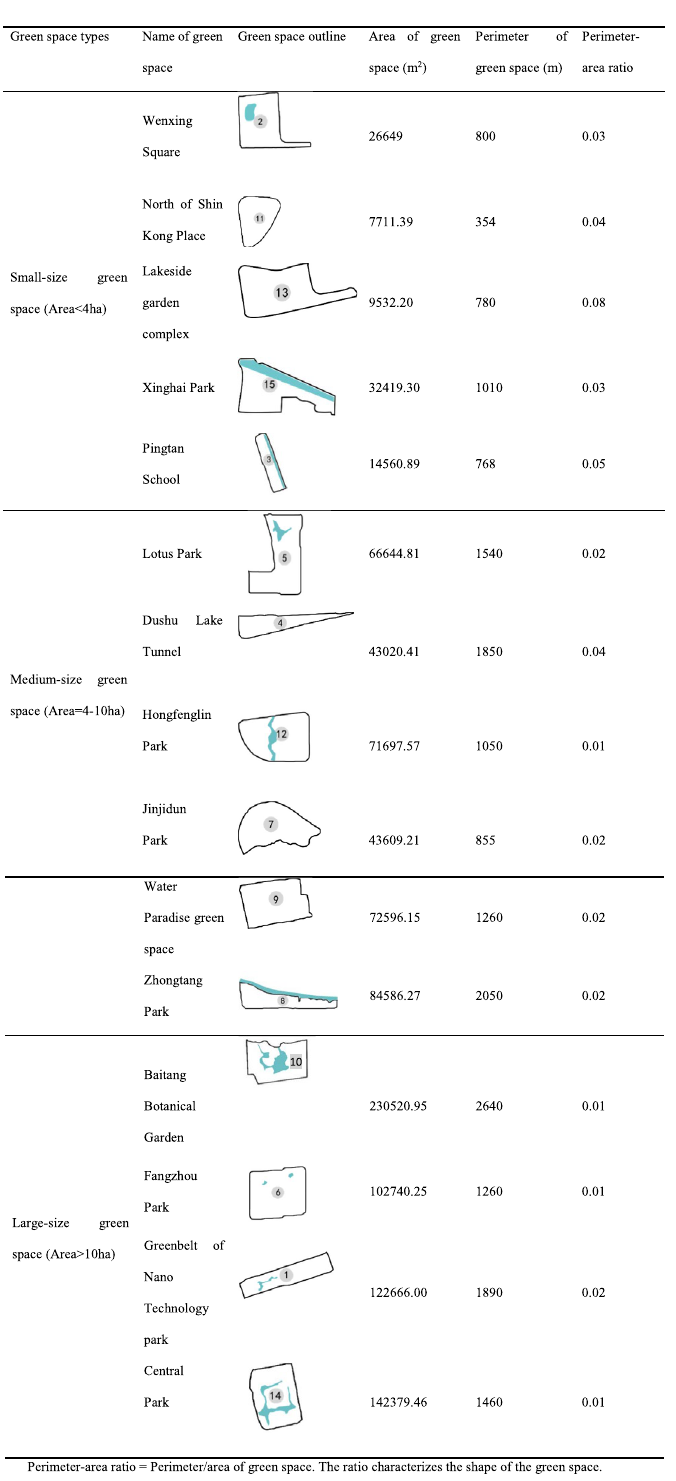
Table 1. Green space outline and structural